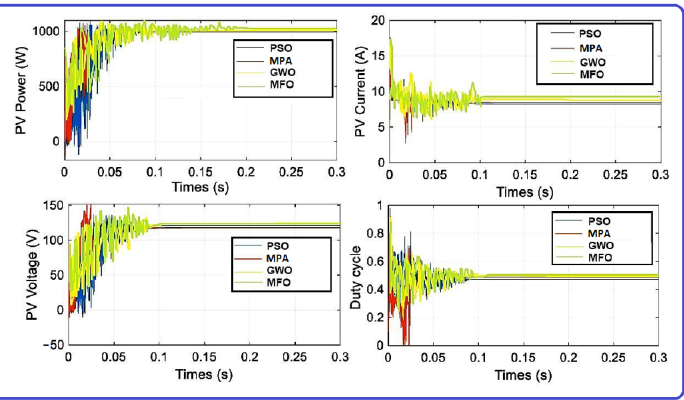
Figure 7. PV power, voltage, current, and duty for MPA, PSO, GWO, and MFO during case 1.